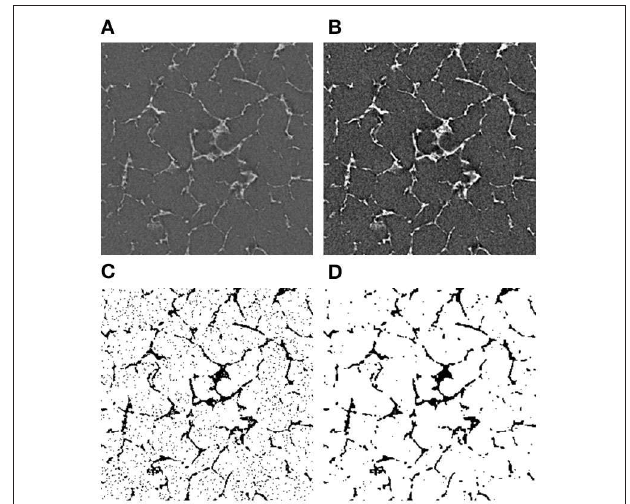
FIGURE 2 | 3D rendering of a silk sponge scaffold reconstructed from computer tomography (CT) slice images. A typical silk sponge scaffold image consisted of 1,000 slices of 992 × 1,014 pixels, at 3 × 3 × 3 µ m 3 voxel size. The z-axis is along the page vertical direction and the syringe direction. of the silk layers in the scaffold. Second, in the mid-q region, we found a broad peak with a varying position. The associated